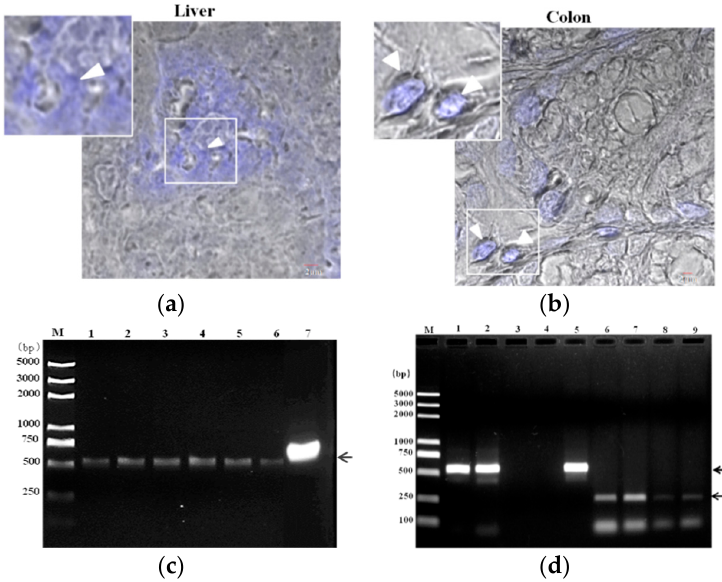
Figure 1. Colonization of E. hellem . ( a ) Liver and ( b ) colon samples were collected from E. hellem infected mice, immediately frozen by liquid nitrogen, and then prepared by frozen sectioning. The existences of E. hellem were detected by calcofluor white (CFW) staining, as shown in blue color (also